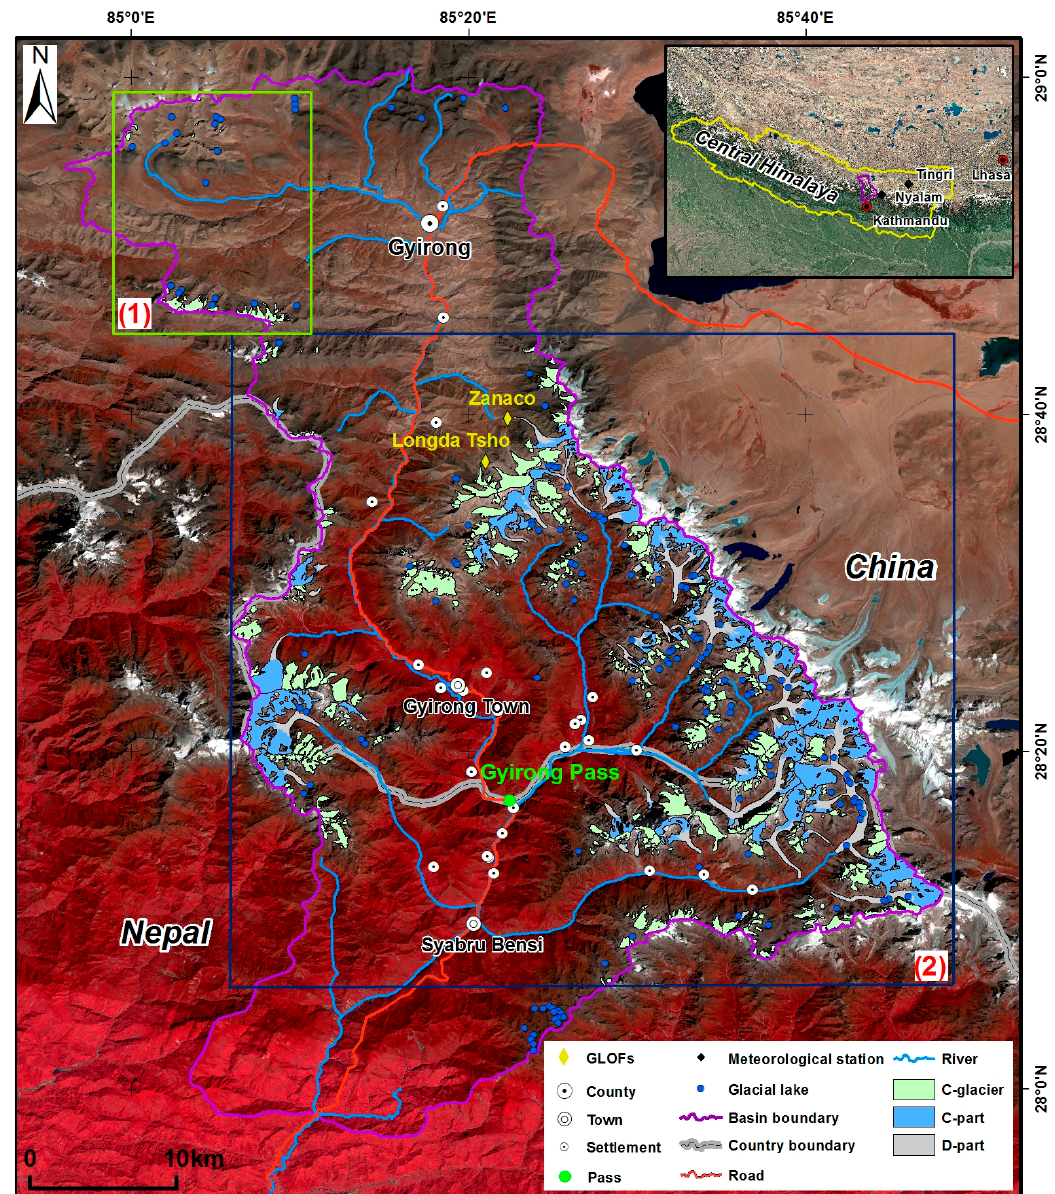
Figure 1. Study area and distribution of glaciers and glacial lakes in 2015. The inset map is from ESRI’s world basemap and the background image was acquired on 25 October 2015 from Landsat 8 OLI. Rectangles 1 and 2 are the areas covered in Figures 2 and 3.